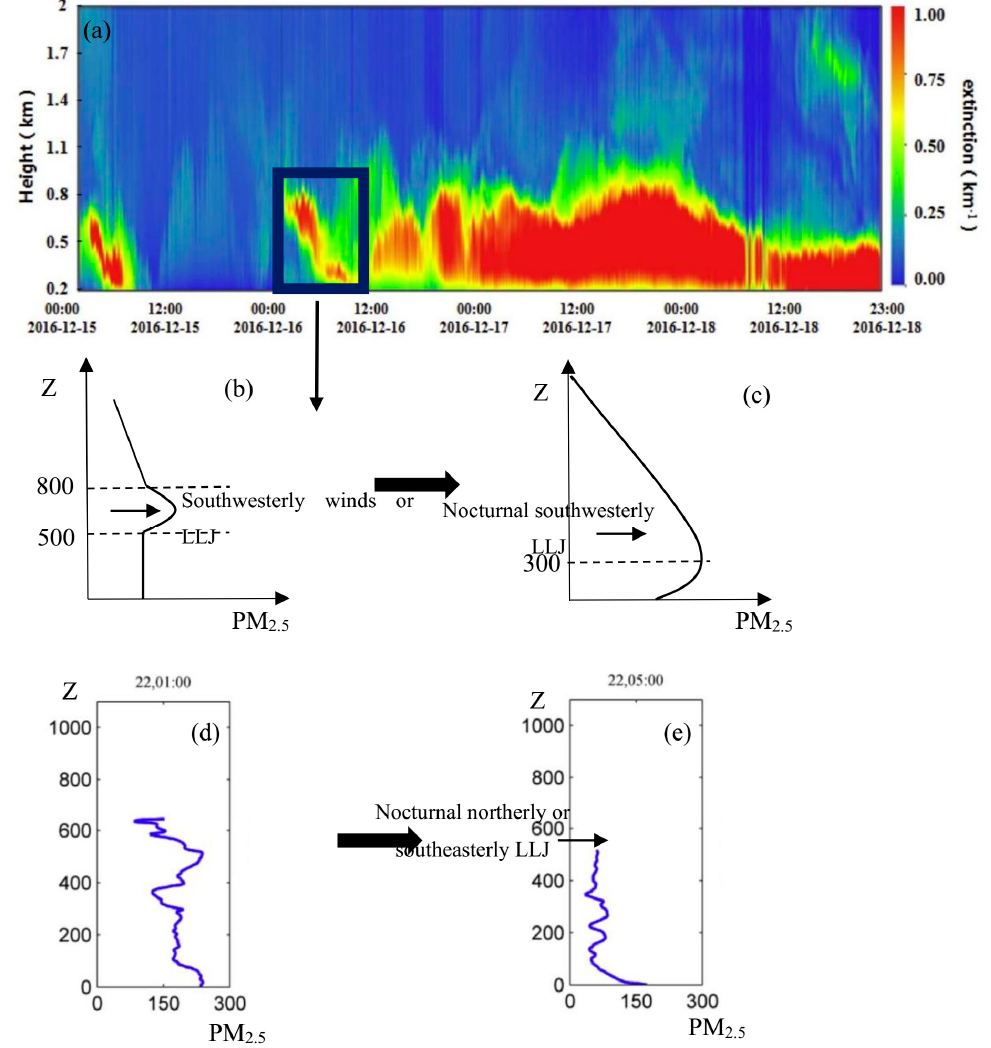
Figure 8. Schematic illustration of how LLJs influence PEs. ( a ) Vertical variations of the light-extinction coefficient of aerosols from 0000 LST 15 December to 2300 LST 18 December (Figure 6 in Han et al. [44]). Profiles of PM 2.5 mass concentration ( b ) accompanied by southwesterly winds or LLJs before the onset of surface PE, and ( c ) accompanied by nocturnal southwesterly LLJs during the formation stage of surface PE. Profiles of PM 2.5 mass concentration ( d ) at 0100 LST 22 December (during PE) (Figure 9 in Han et al. [44]), and ( e ) with nocturnal northerly or southeasterly LLJ at 0500 LST 22 December (during the dispersion stage of PE).